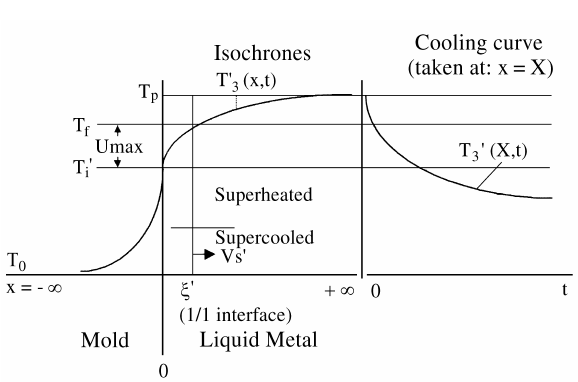
Figure 1. Undercooling, superheated / supercooled liquid interface and the resulting cooling curve created by a thermal shock in a liquid metal against a cooler mold, before the nucleation’s